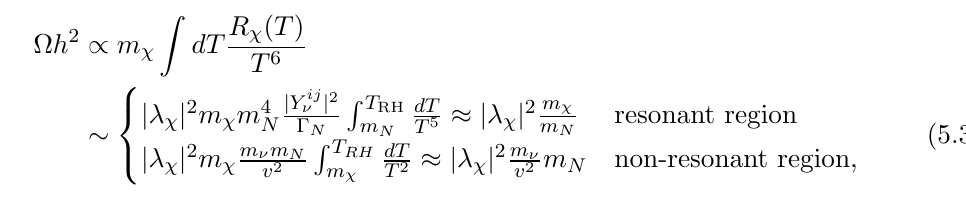
Figure 7 . Contours of log ( (cid:21) (cid:31) ) providing the correct relic density for (cid:31) in the m (cid:31) - m N plane, when 10 only s-channels are considered. The blue and green contours are for T i = 10 3 GeV and 10 14 GeV, respectively, with T r = 10 MeV. The out-of-equilibrium condition for freeze-in DM is no longer hold in the hatched region. Solid (dashed) red lines are for m N = m S + m (cid:31) ( m N = m h = 125 GeV).